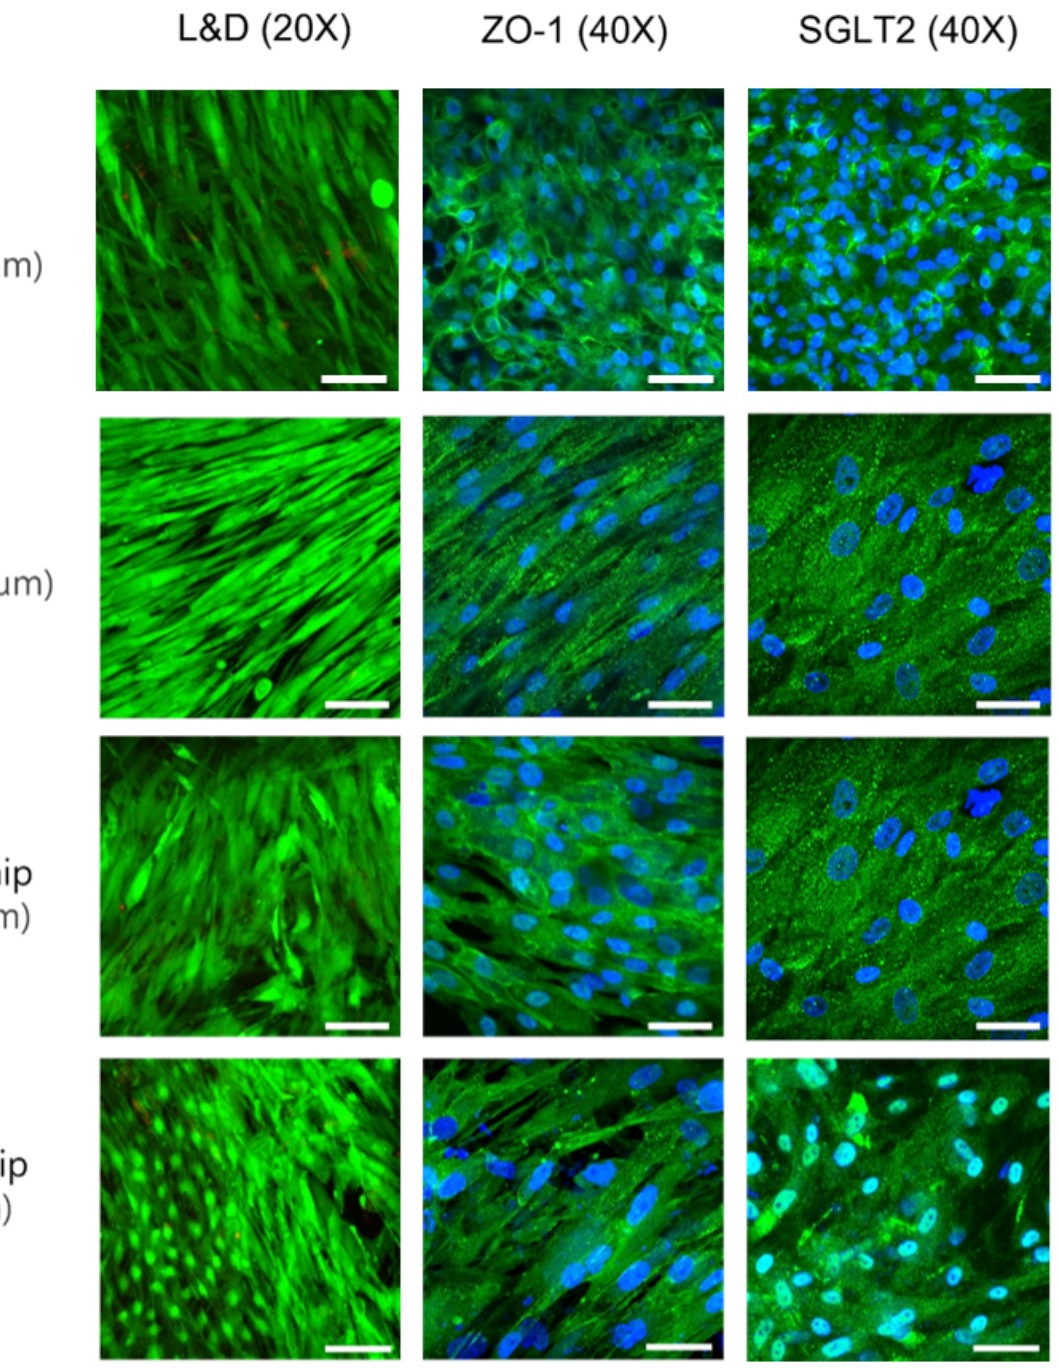
Figure 3. Confocal microscope HUVEC’s L&D images (4×, 20×) and immunofluorescence images (40×) on TW and I-M chip by membrane pore size.